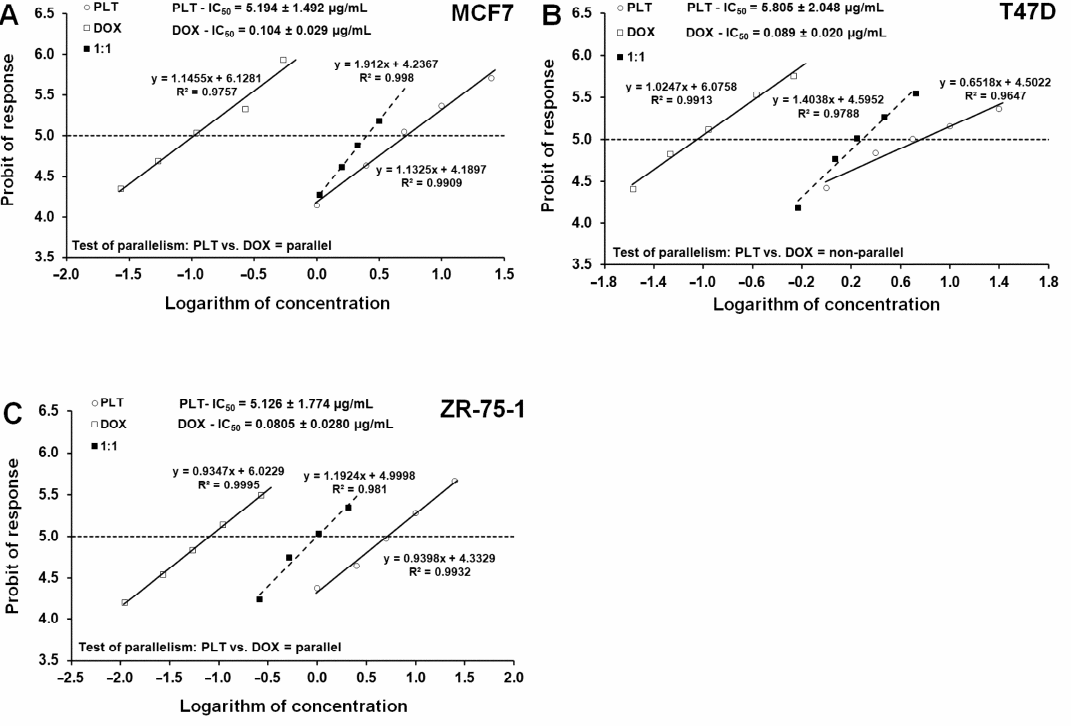
Figure 8. ( A – C ) Log-probit dose–response relationship curves (DRRCs) for palmatine (PLT) and doxorubicin (DOX) administered alone, and in combinations at the fixed ratio of 1:1 (dotted line), illustrating the anti-proliferative effects of the drugs in the human breast cancer cell lines (MCF7, T47D, and ZR-75-1) measured in vitro by the MTT assay. Doses of PLT and DOX administered separately and the mixture of the drugs at the fixed-ratio combination of 1:1 (dotted line) were transformed into logarithms, whereas the anti-proliferative effects produced by the drugs in the human breast cancer cell lines (MCF7, T47D, and ZR-75-1) measured in vitro by the MTT assay were transformed into probits according to Litchfield and Wilcoxon (1949). Linear regression equations of DRRCs are presented on the graph; where y is the probit of response, and x is the logarithm (to the base 10) of a drug dose, and R 2 is the coefficient of determination. Test for parallelism revealed that the experimentally determined DRRCs for PLT and DOX (administered alone) are not parallel to one another in T47D cancer cell line and are parallel to one another in MCF7 and ZR-75-1 cancer cell lines. 2.5. Isobolographic Analysis of Interaction between DOX and PLT in Human Breast Cancer Cell Lines The isobolographic analysis of interaction for non-parallel DRRCs revealed that the mixture of DOX with PLT at the fixed-ratio of 1:1 exerted additive interaction on T47D cells (Figure 9B). The experimentally derived IC 50exp value for this fixed-ratio combination was 1.942 ± 0.411 µg/mL, whereas the additively calculated IC 50add values were 2.089 ±